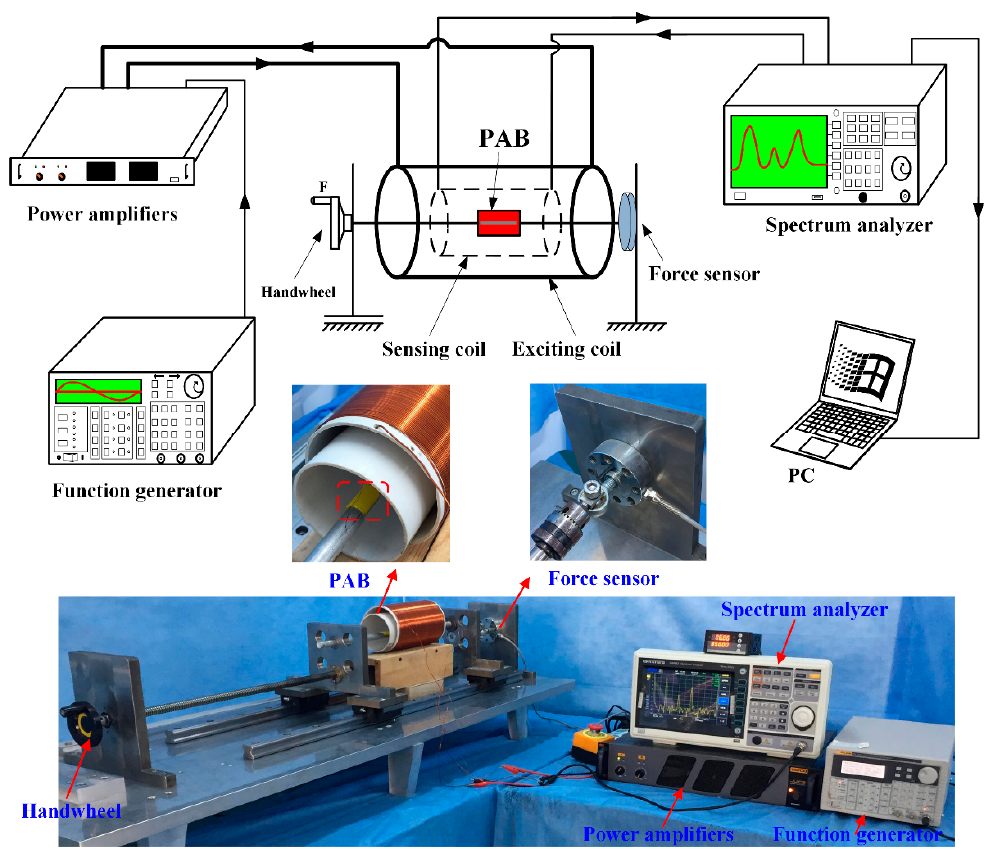
Figure 3. Experimental platform devices. The external compressive force ( F ) was applied on the PAB by the handwheel.